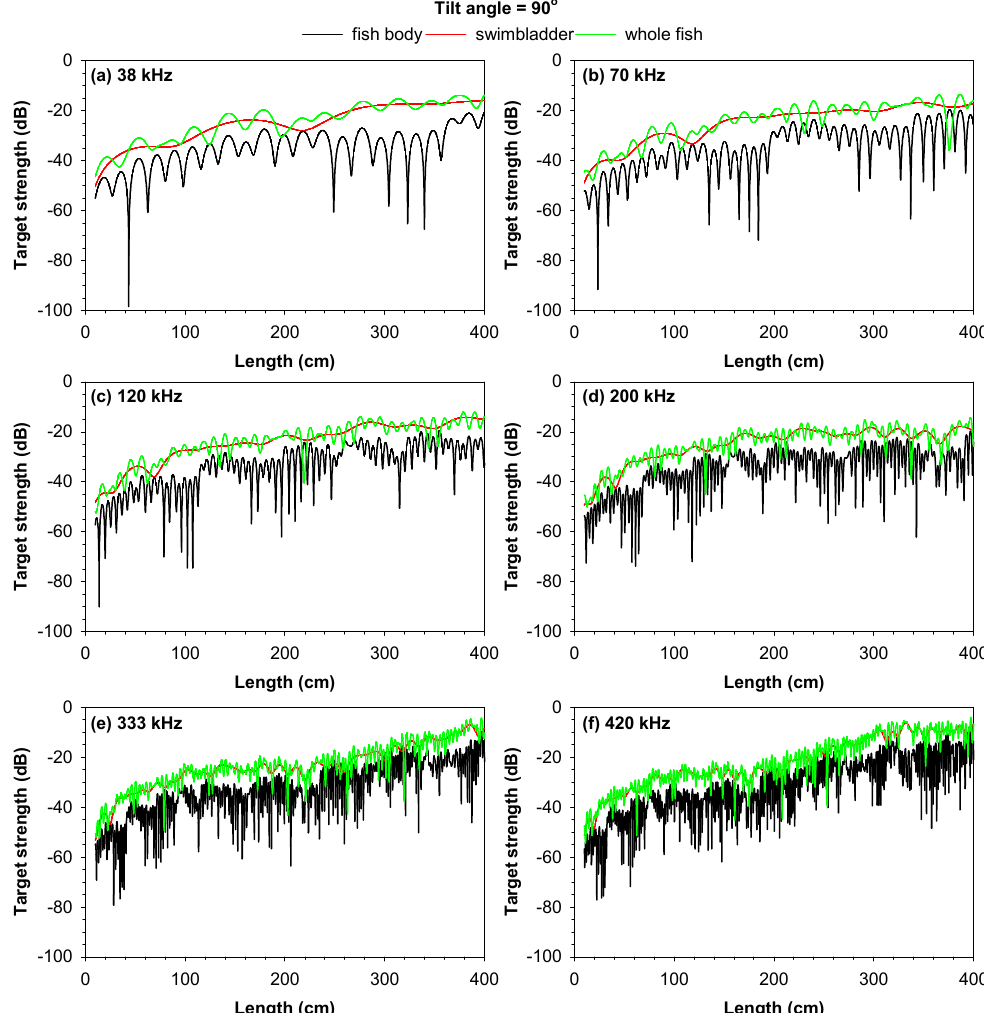
Figure 6. Estimated TS of Chinese sturgeon as a function of body lengths in six acoustic frequencies: ( a ) 38 kHz; ( b ) 70 kHz; ( c ) 120 kHz; ( d ) 200 kHz; ( e ) 333 kHz; and ( f ) 420 kHz.